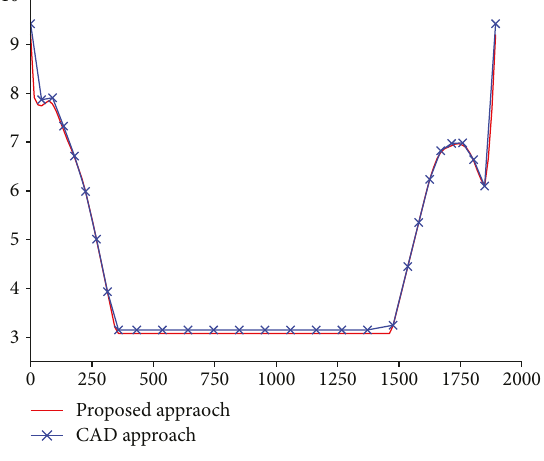
Figure 11: Uni fi ed designs.